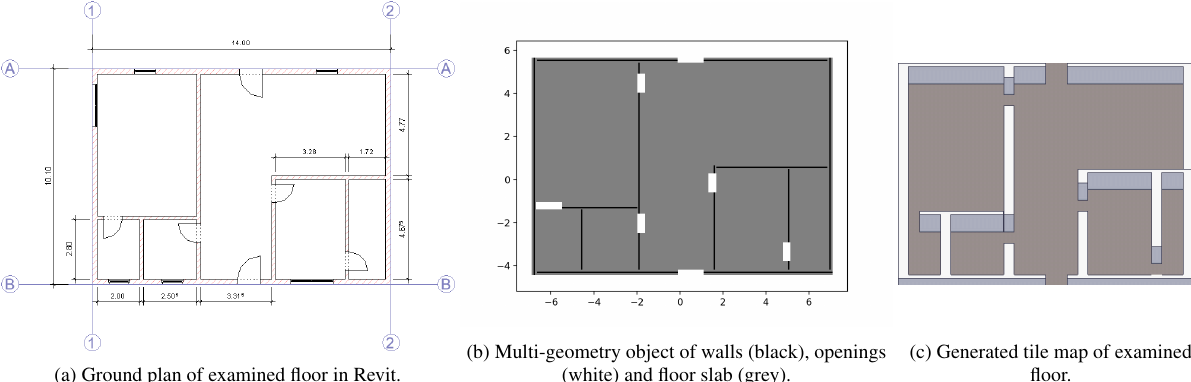
(b) Multi-geometry object of walls (black), openings (c) Generated tile map of examined (a) Ground plan of examined floor in Revit. (white) and floor slab (grey). floor. Figure 4. Conversion of an IFC floorplan (a) to WorkAdventure tile map (c) via an intermediate data structure